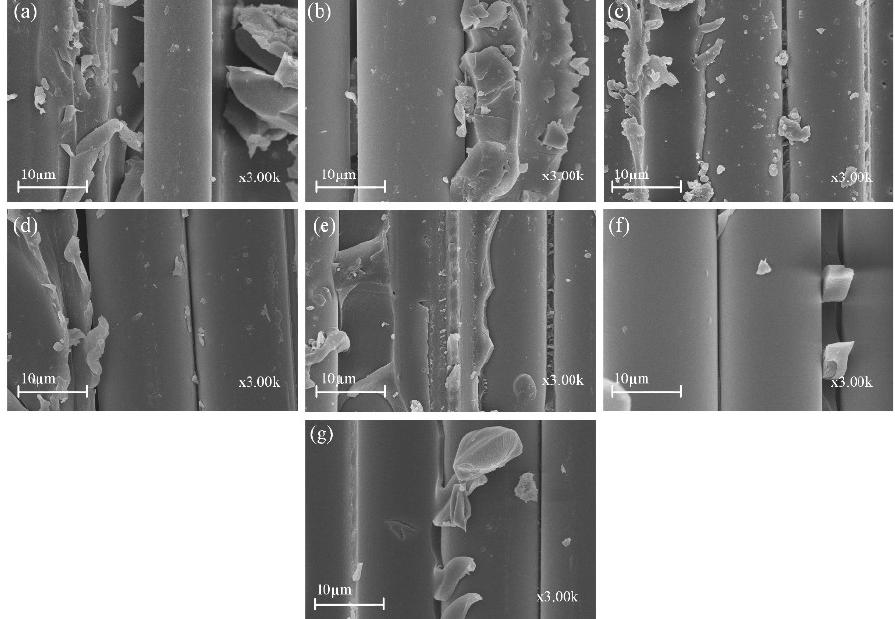
Figure 10. SEM images of tensile specimens in seawater aged condition ( a ) GF ( b ) BF ( c ) GB1 ( d ) GB2 ( e ) GB3 ( f ) GB4 ( g ) GB5.